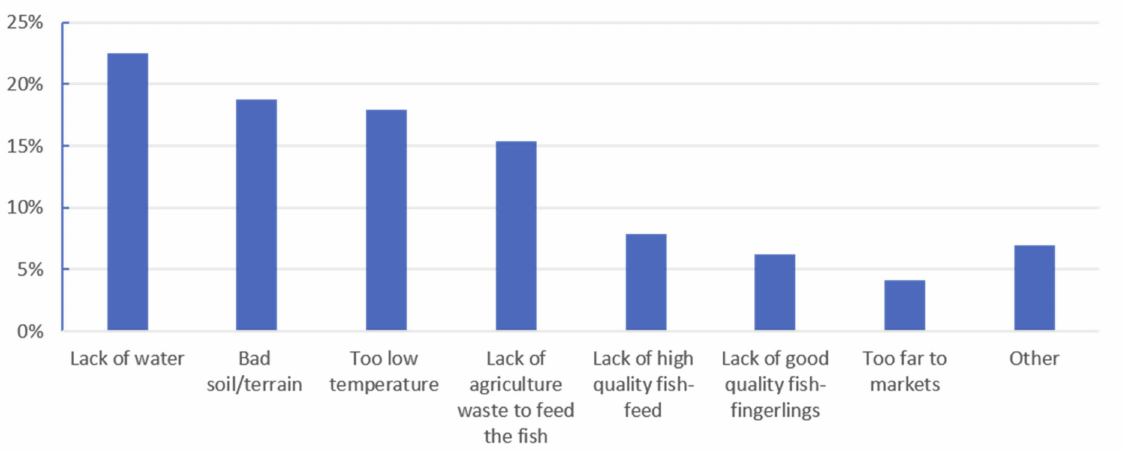
Figure 7. The relative importance of different constraints to development of fish pond farming as ranked by 16 regional fisheries officers in Tanzania. Table 6. Regional fisheries officers (16) perception on aquaculture related issues in Tanzania. Regions with fish feed froducer (%) 38 Regions with fish hatcheries (%)